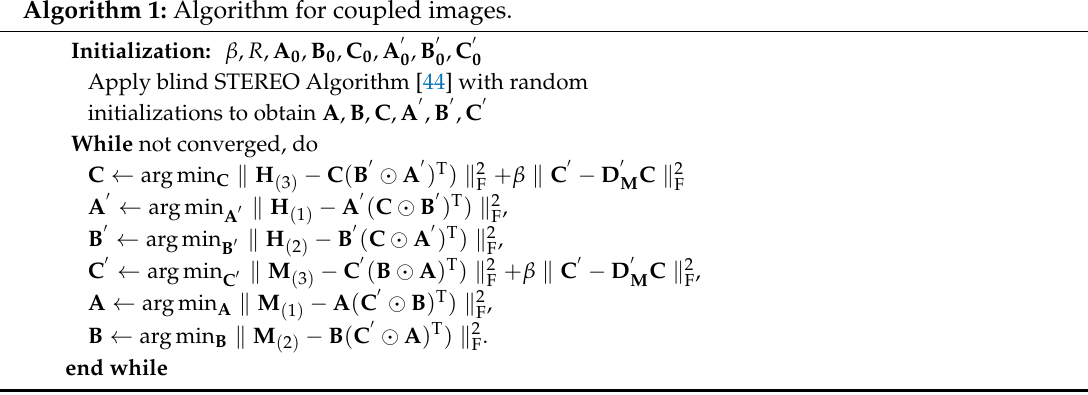
Algorithm 1: Algorithm for coupled